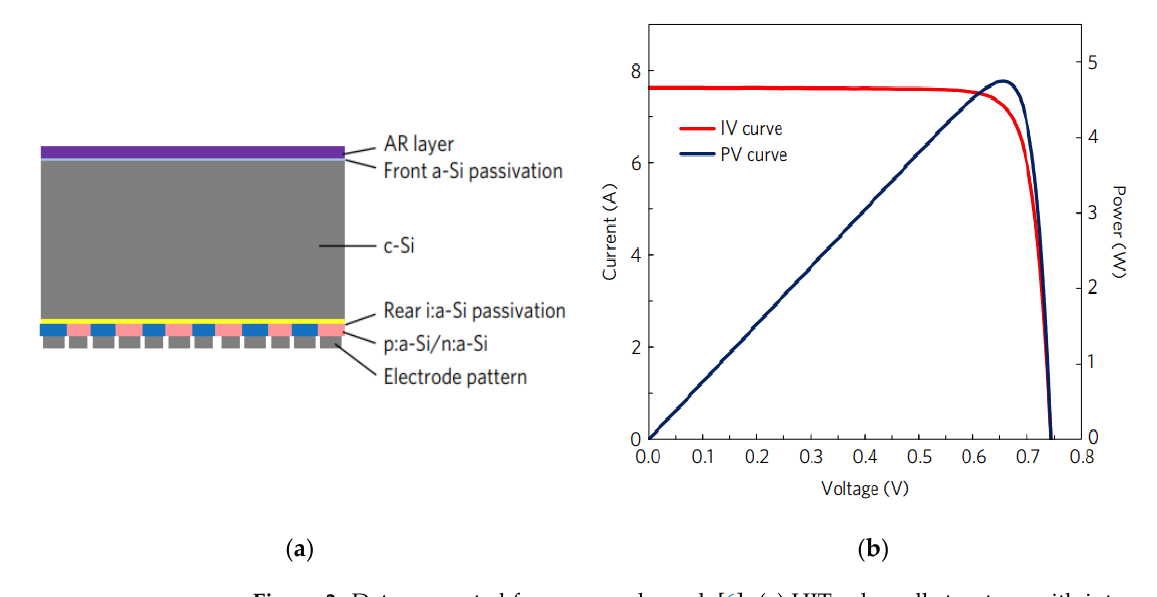
Figure 3. Data presented from research work [6]: ( a ) HJT solar cell structure with integrated rear contacts; ( b ) IV-curve of the presented structure.